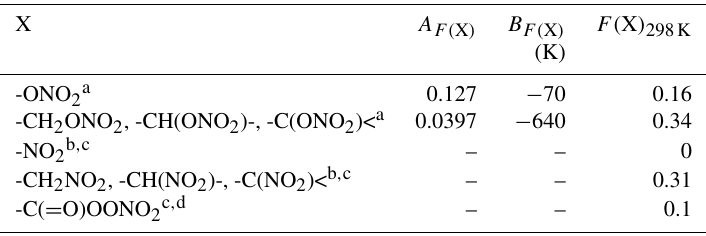
Table 9. Substituent factors, F( X ) , for oxidized nitrogen groups, and their temperature dependences described by F( X ) = A F( X ) exp ( − B F( X ) /T )